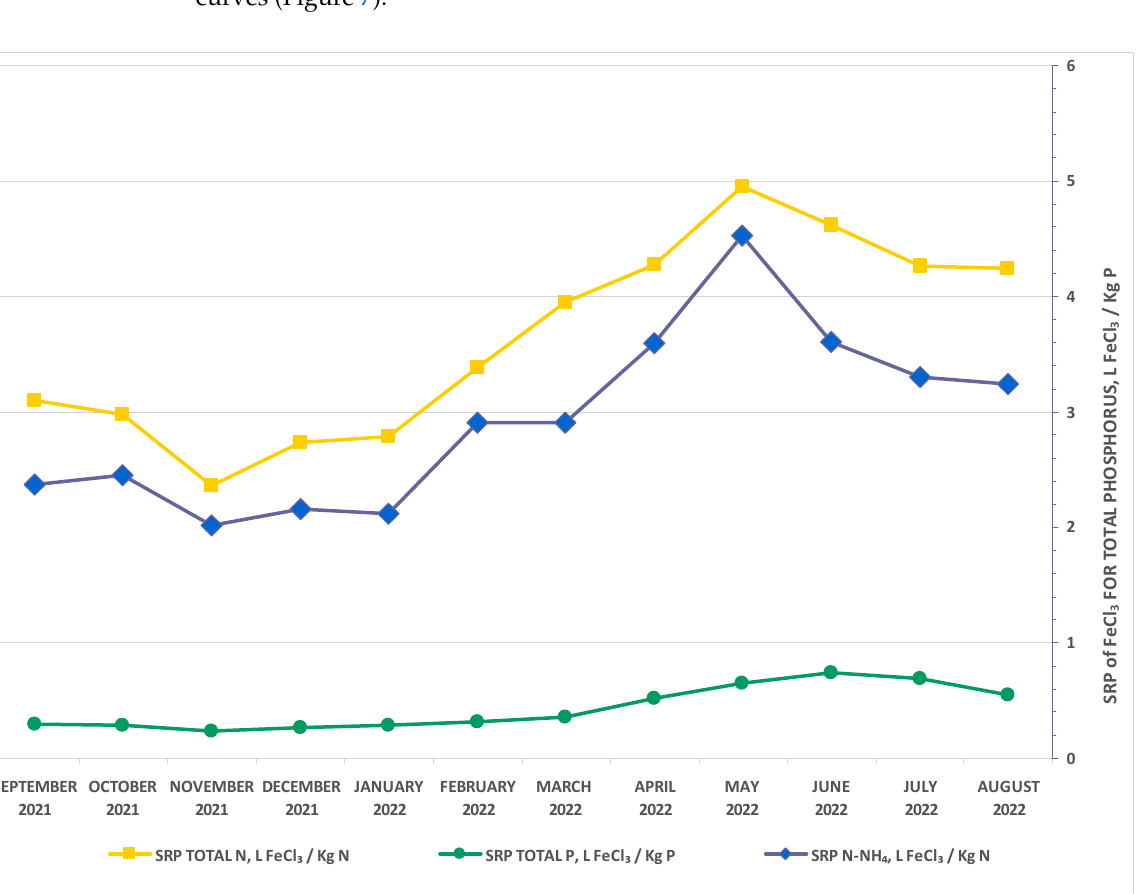
Figure 7. SRPs for total nitrogen, ammonia nitrogen, and phosphorus.